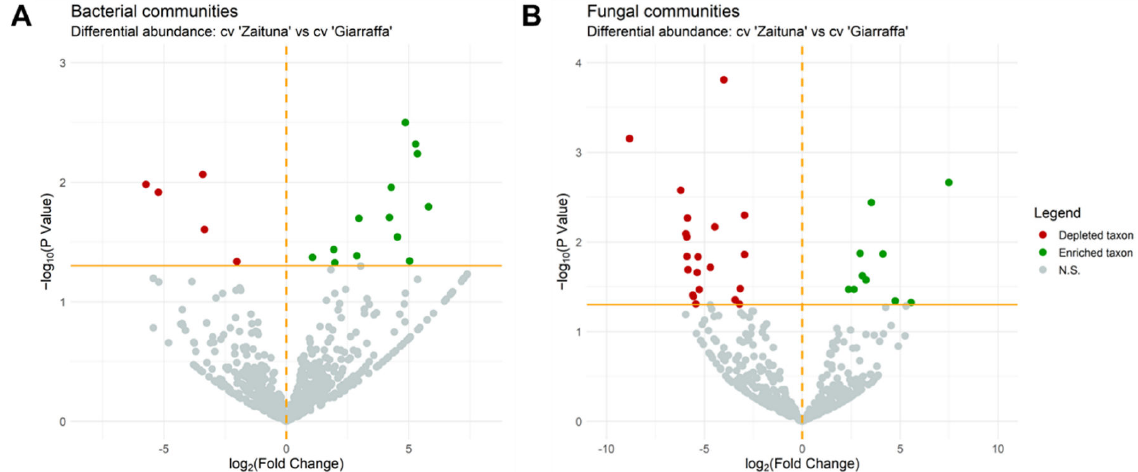
Figure 6. Differentially abundant bacterial ( A ) and fungal ( B ) OTUs. Log fold change values and negative log-transformed p -values were reported on the x-axis and y-axis, respectively. The orange horizontal line represents the p -value threshold transformed into a negative logarithm (1.30). The orange dotted vertical line represents the log 2 fold change cut-off (0), which separates the significantly enriched (green dots) and the depleted (red dots) bacterial and fungal OTUs from the nonsignificant ones (grey